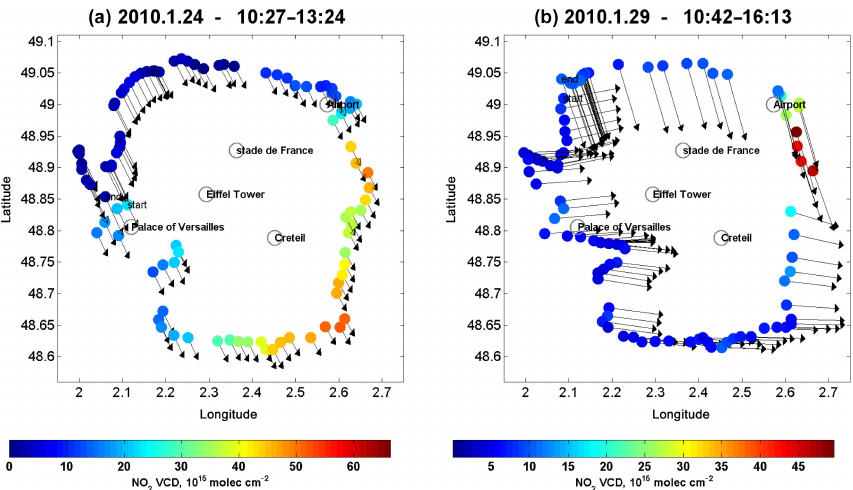
Figure 11. Measured NO 2 VCDs and corresponding wind vectors for 2 selected days with extremely variable wind fields. On 24 January 2010 (a) the wind speed and on 29 January 2010 (b) the wind direction showed large variations.